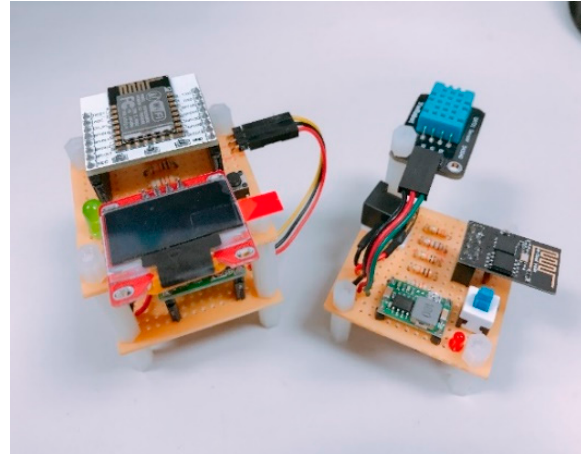
Figure 4. ESP-01 and ESP-12F devices.